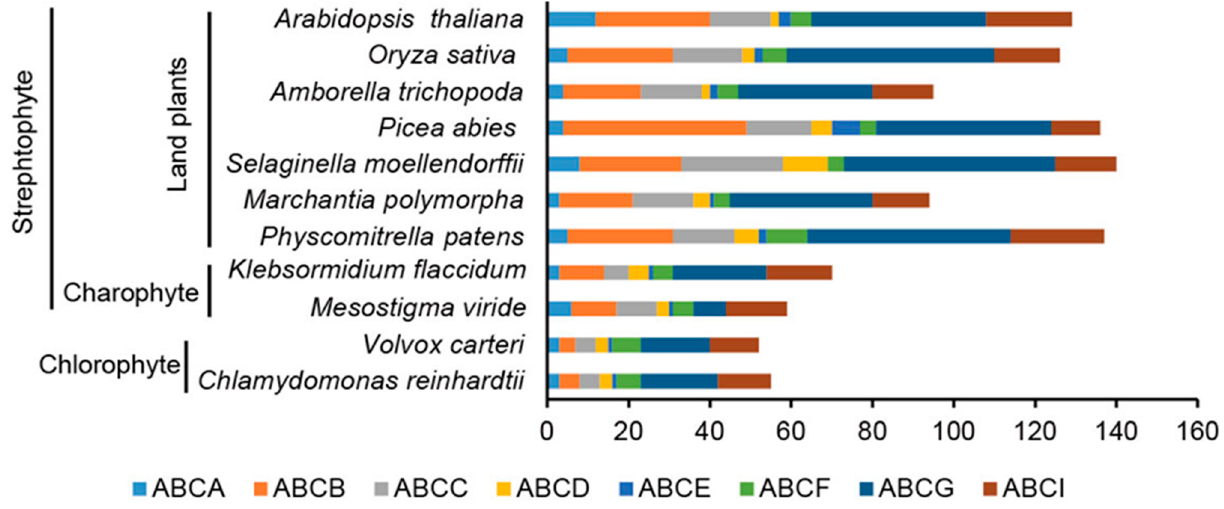
Figure 1. Number of ABC proteins from 11 evolutionarily representative plant species. Each subfamily (ABCA, ABCB, ABCC, ABCD, ABCE, ABCF, ABCG, and ABCI) is labeled with a different color.